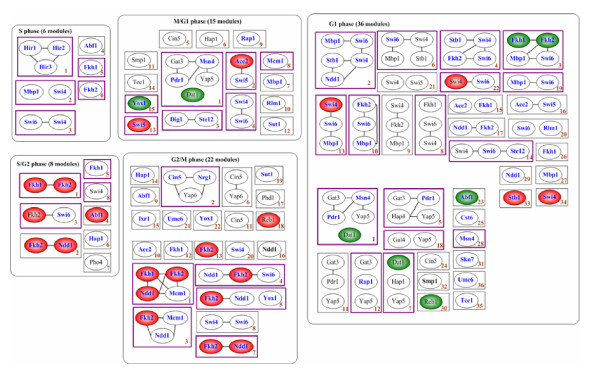
The 87 TRMs identified in this study. Each rectangle stands for a module and the ovals in a rectangle indicate the TFs that regulate the module. TF name is colored blue if its function is consistent with one of the module's over-represented MIPS functional categories with adjusted p-value < 0.05 (after the Bonferroni correction for multiple tests) using the cumulative hypergeometric distribution or black if not. Two ovals are connected by a line if previous studies indicated that the two TFs interact with each other physically (forming a protein complex), functionally (in the same cellular process) or statistically (co-occurrence) [19-22,24]. An oval is colored red (green) if the TF is identified as an activator (repressor). The periphery of a rectangle is colored purple if this module implicates important TF combinations or is discussed in the text.